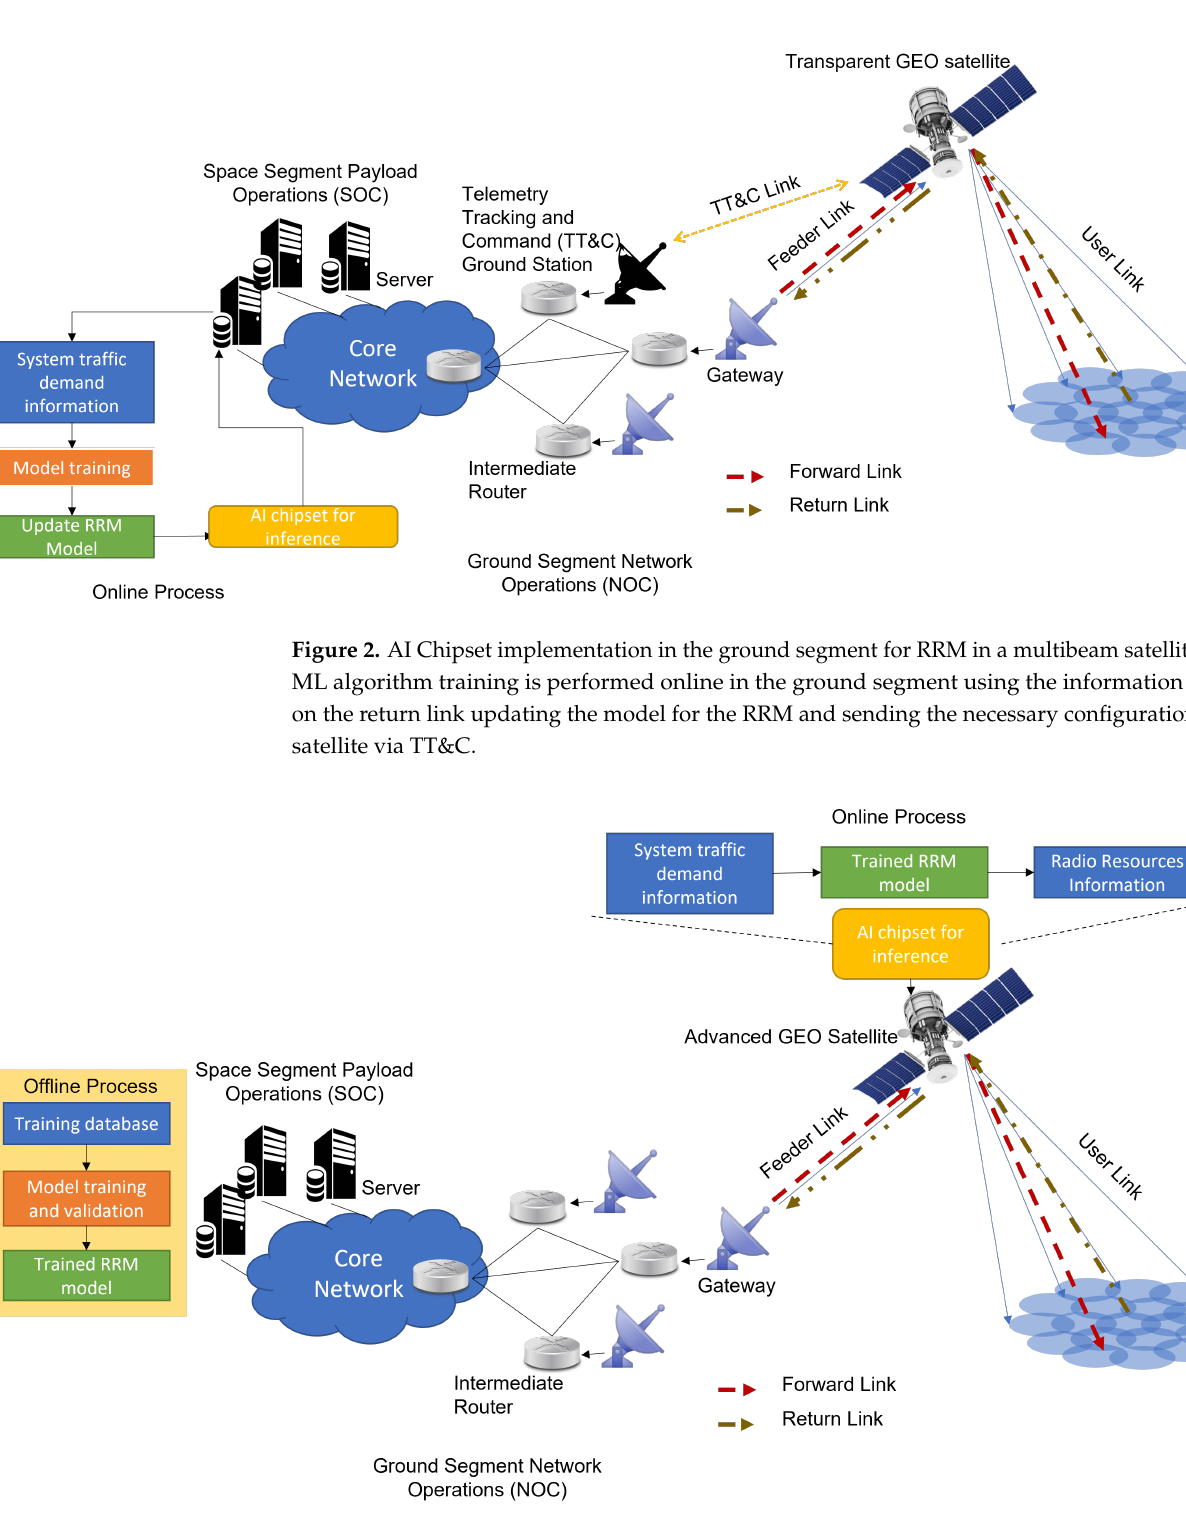
Figure 3. AI Chipset implementation in the space segment for RRM in a multibeam satellite system. ML algorithm training is performed offline in ground segment with a training database, thus saving the model obtained and the AI chipset can go onboard the satellite using the model for